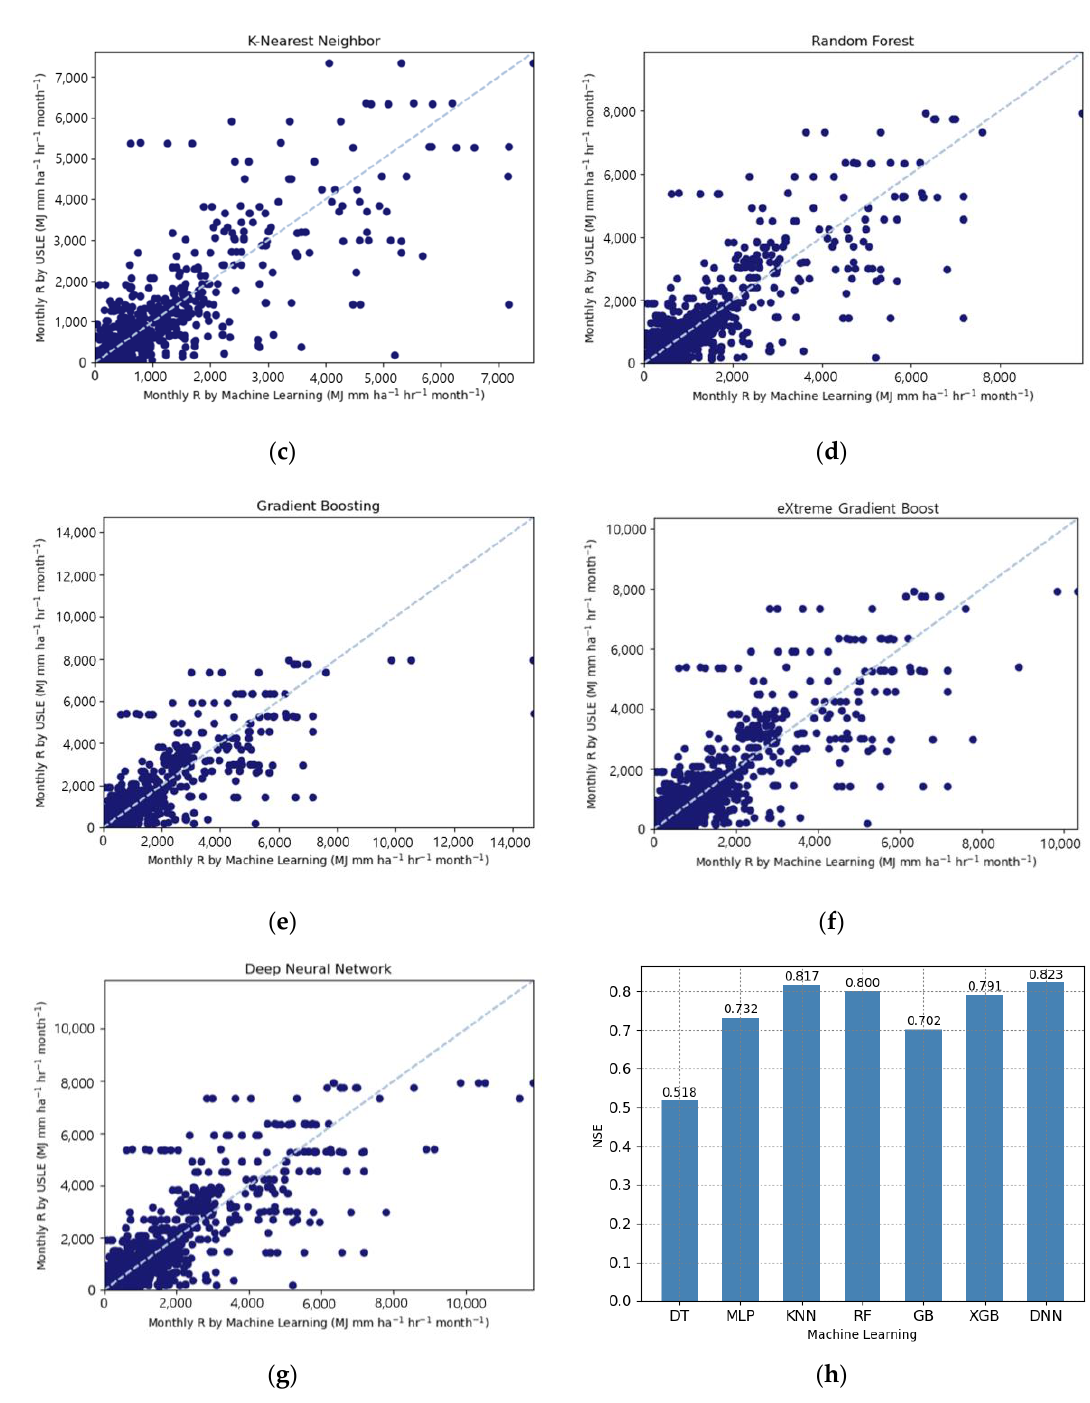
Figure 5. Comparison of ( a ) Decision Tree, ( b ) Multilayer Perceptron, ( c ) K-Nearest Neighbor, ( d ) Random Forest, ( e ) Gradient Boosting, ( f ) eXtreme Gradient Boost, and ( g ) Deep Neural Network calculated R-factor with validation data, and ( h ) comparison of machine learning accuracy.